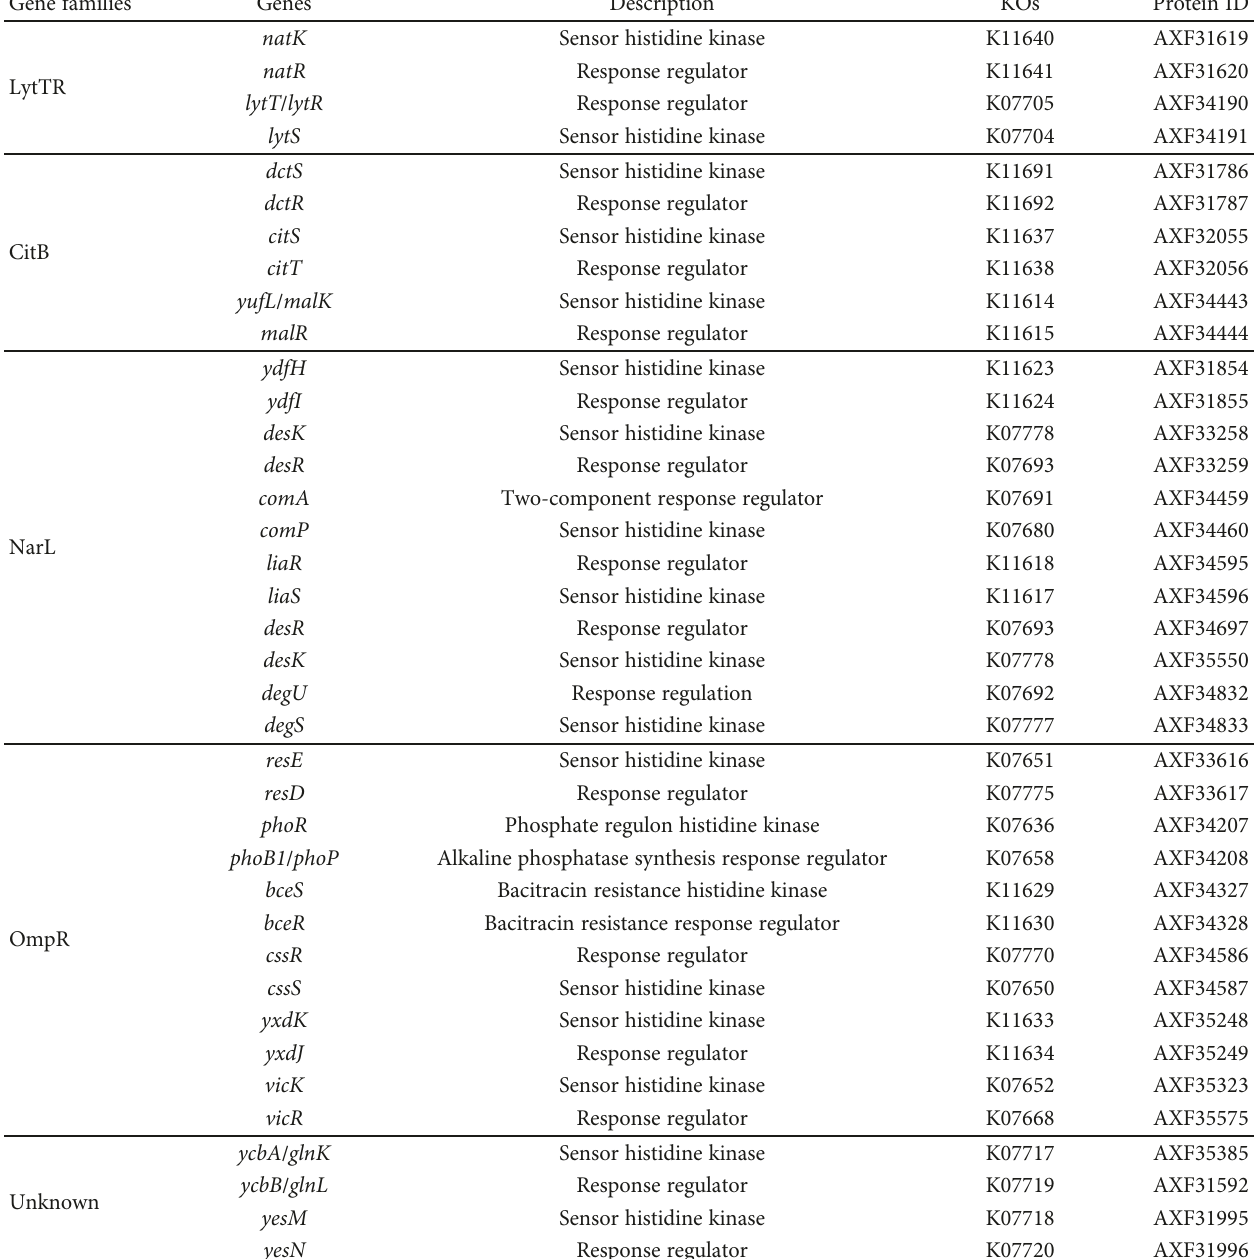
Table 7: The two-component signaling systems of B. subtilis